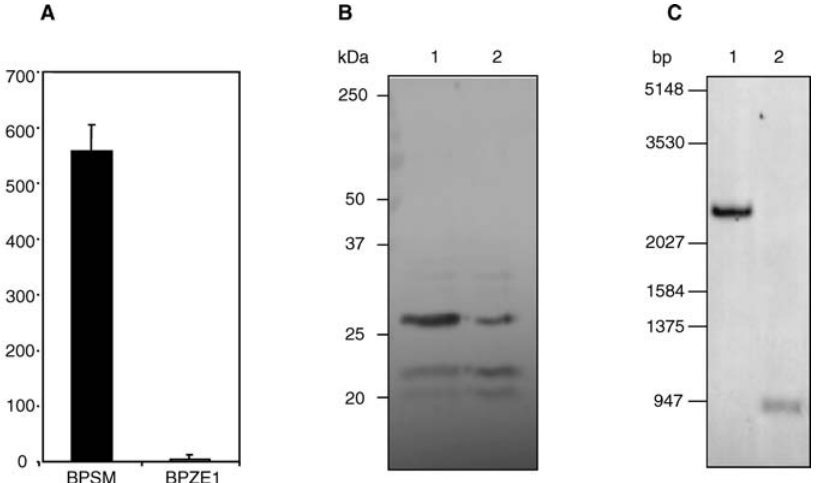
Figure 1. Characterization of B. pertussis BPZE1 (A) TCT present in culture supernatants of BPSM and BPZE1 expressed as means of nM/OD 540nm ( 6 standard error) of three separate cultures for each strain. (B) Immunoblot analysis of PTX production in the culture supernatants of BPSM (lane 1) and BPZE1 (lane 2). The sizes of the molecular weight (M r ) markers are expressed in kDa and given in the left margin. (C) Southern blot analysis of the dnt locus in BPSM (lane 1) and BPZE1 (lane 2). The lengths of the size markers are indicated in base pairs (bp) are shown in the left